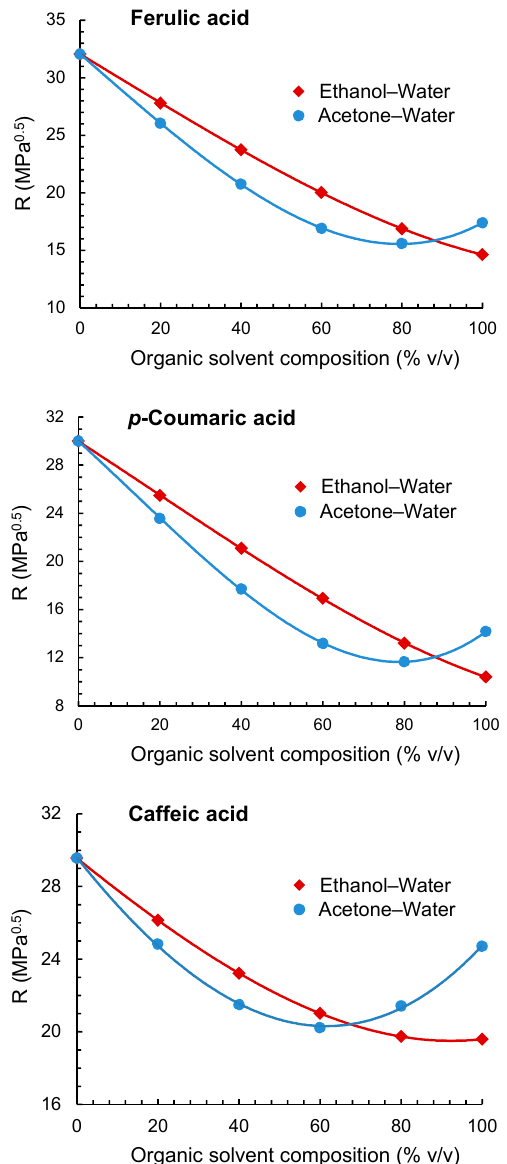
Figure 5. Hansen solubility parameter distance (R) of ferulic, p -coumaric and caffeic acids in water– organic solvent mixtures.